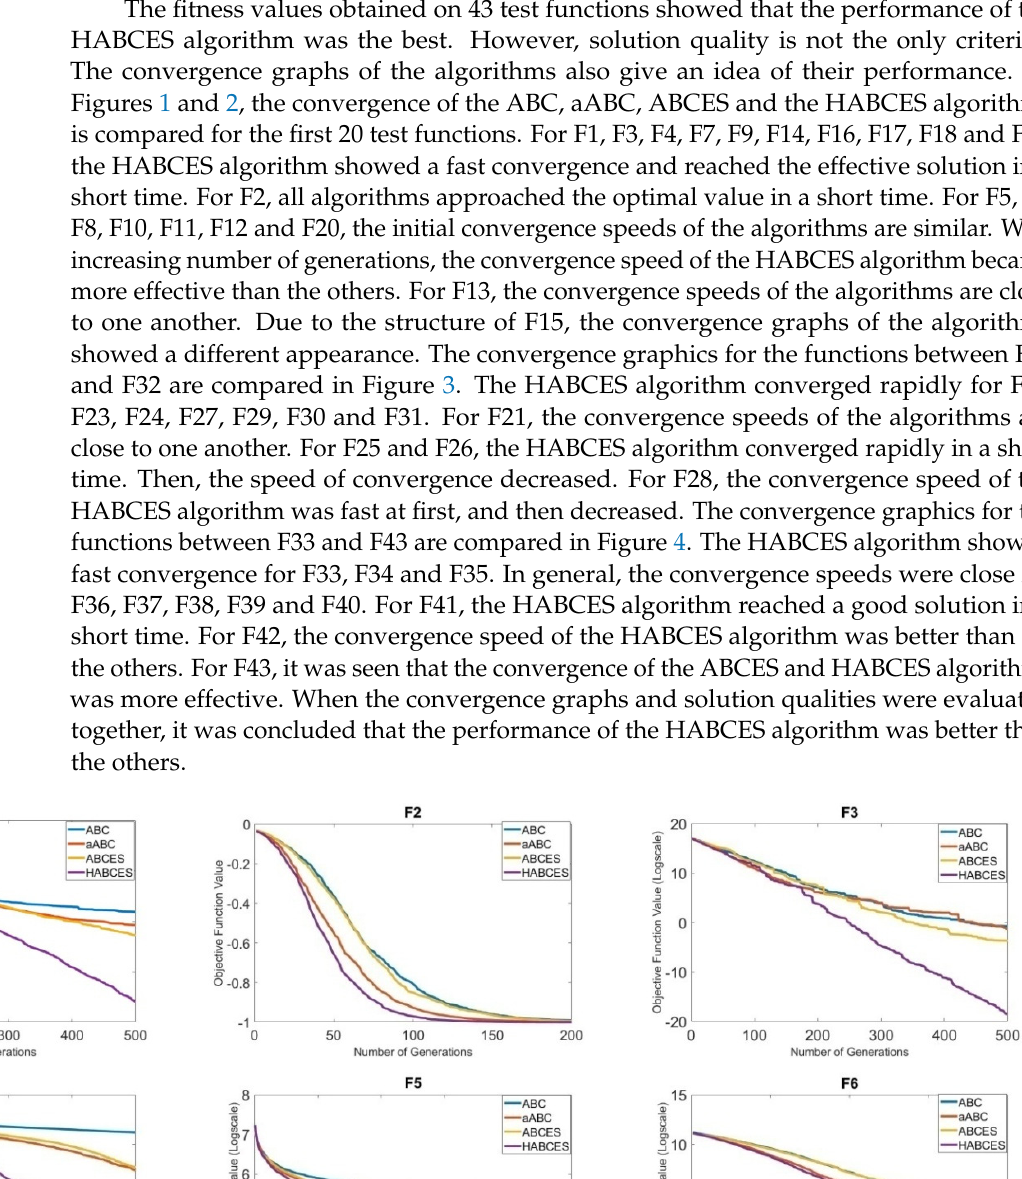
Figure 1. Comparison of the convergences of the ABC, aABC, ABCES and HABCES algorithms when solving high-dimensional global optimization problems (F1–F15).